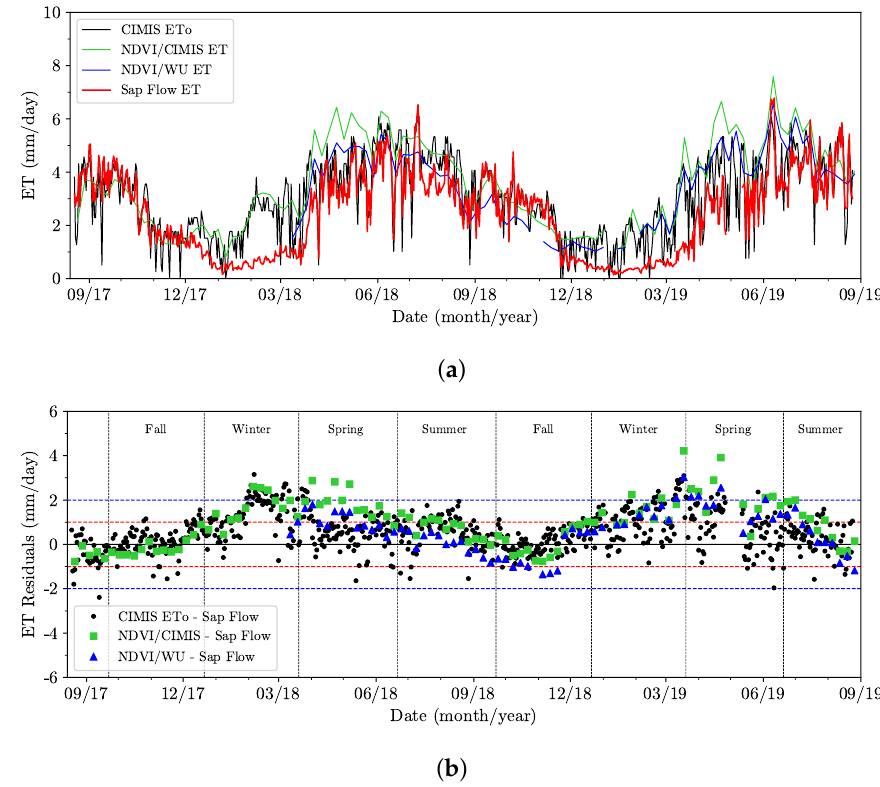
Figure 9. A plot comparing ( a ) the sap flow-predicted riparian forest ET to the other methods and ( b ) the corresponding residuals over study period. The dashed red and blue lines represent residual bounds of ± 1.0 and ± 2.0 mm/d, respectively.